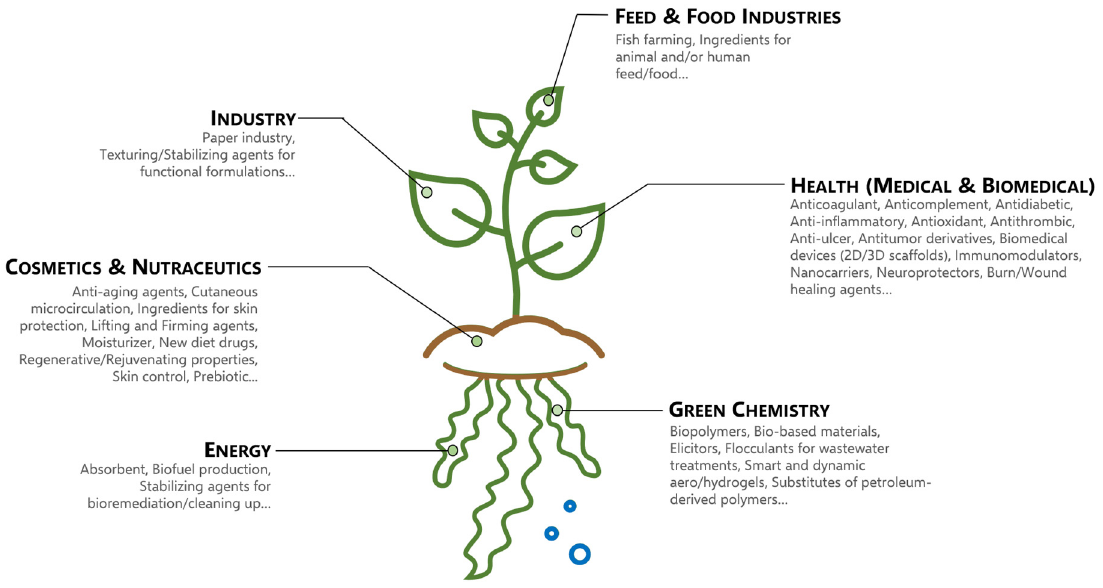
Figure 5. Main probable uses of African poly- and oligosaccharides from plants and macroalgae for the following decades.